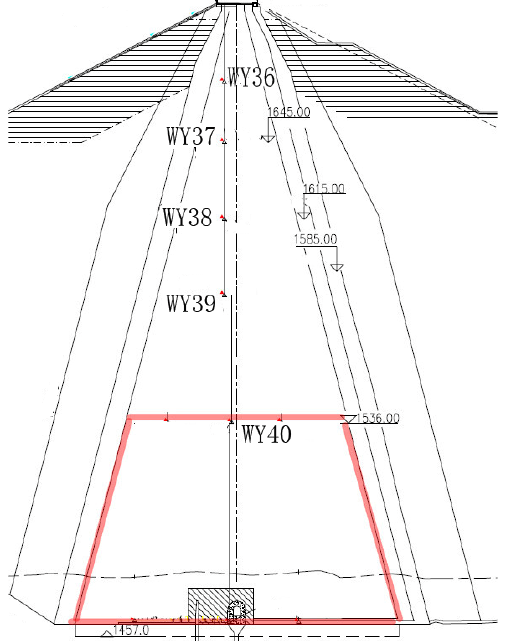
Figure 6. Monitoring arrangement of core wall.